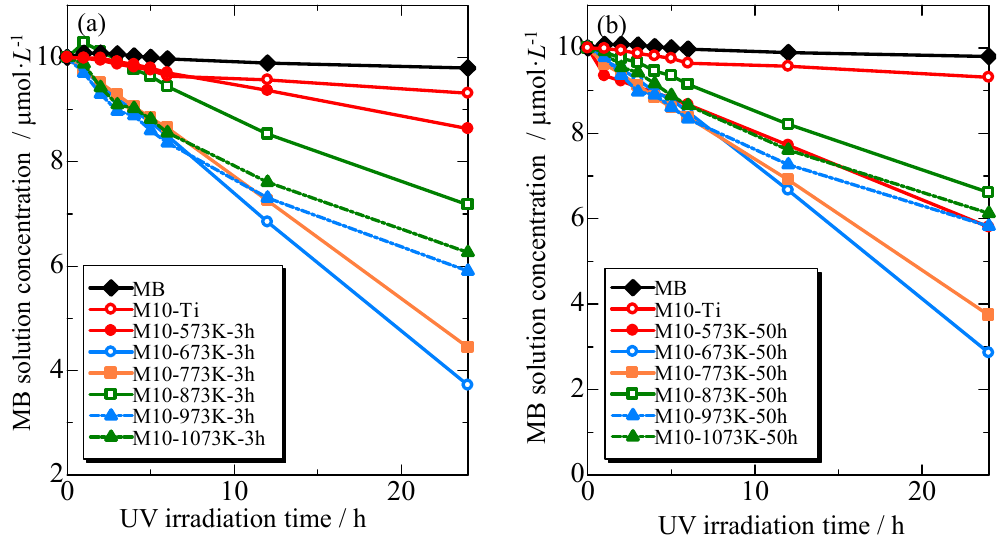
Figure 30. Relationship between MB solution concentration and UV irradiation time of